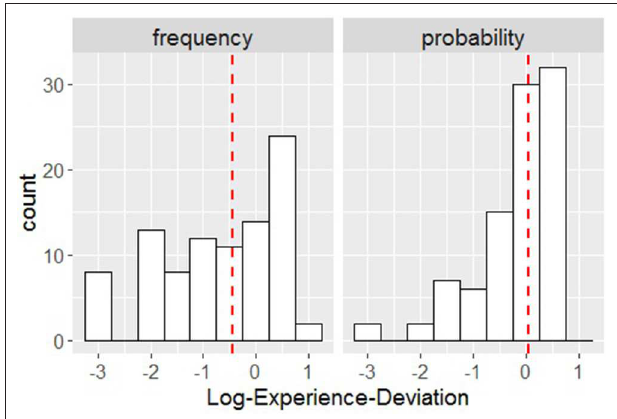
FIGURE 2 | Distribution of Log-Experience-Deviation for frequency (Left) and probability (Right) ; the vertical red dashed lines represent the medians.